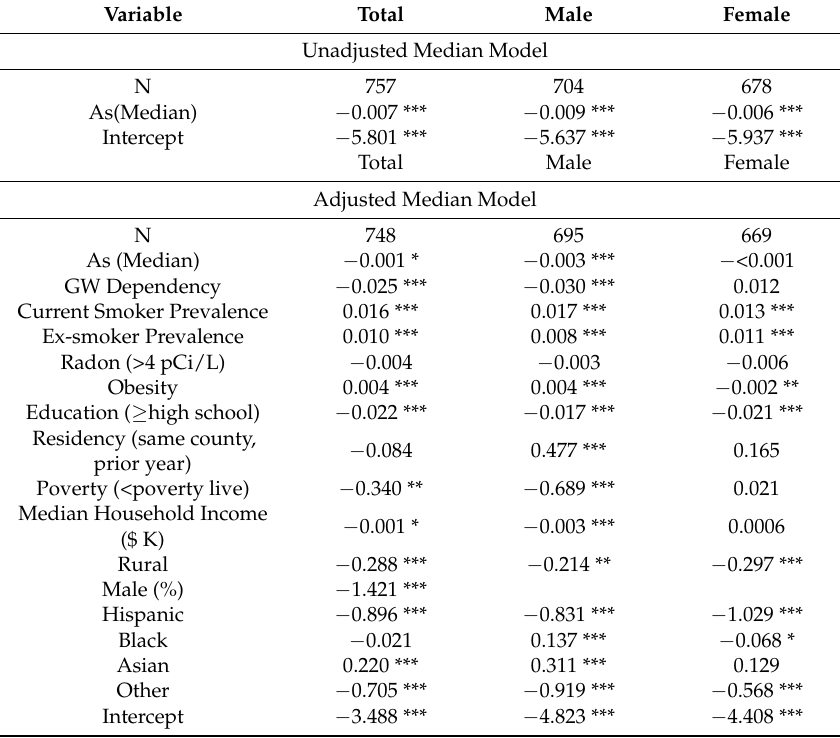
Table 2. Unadjusted and adjusted Poisson log-linear models on lung cancer